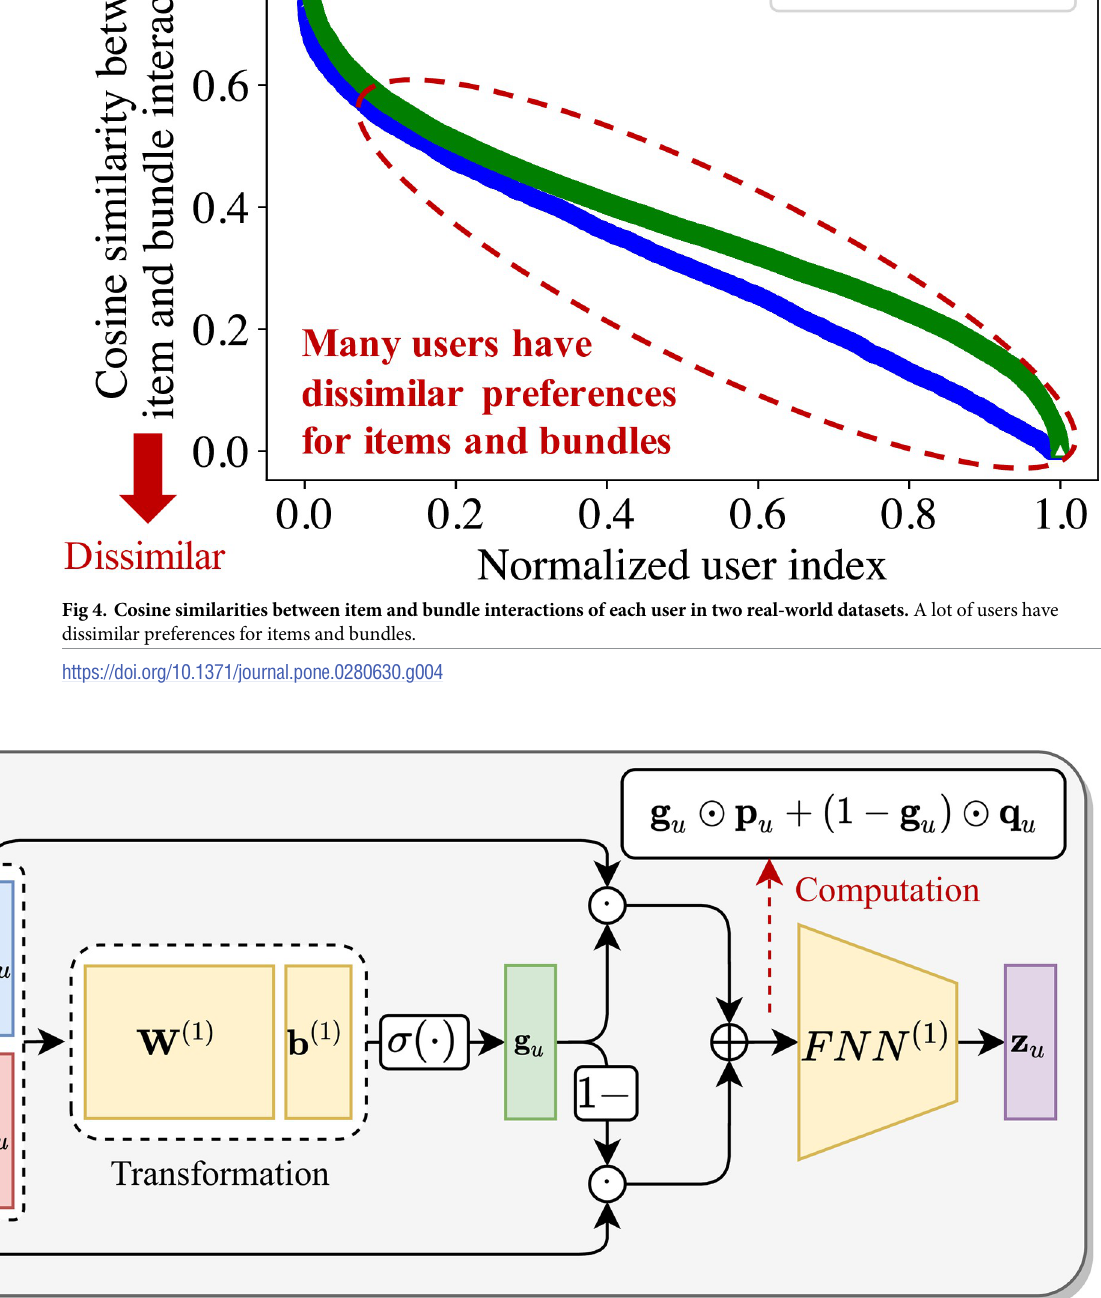
PLOS ONE | https://doi.org/10.1371/journal.pone.0280630 March 16,